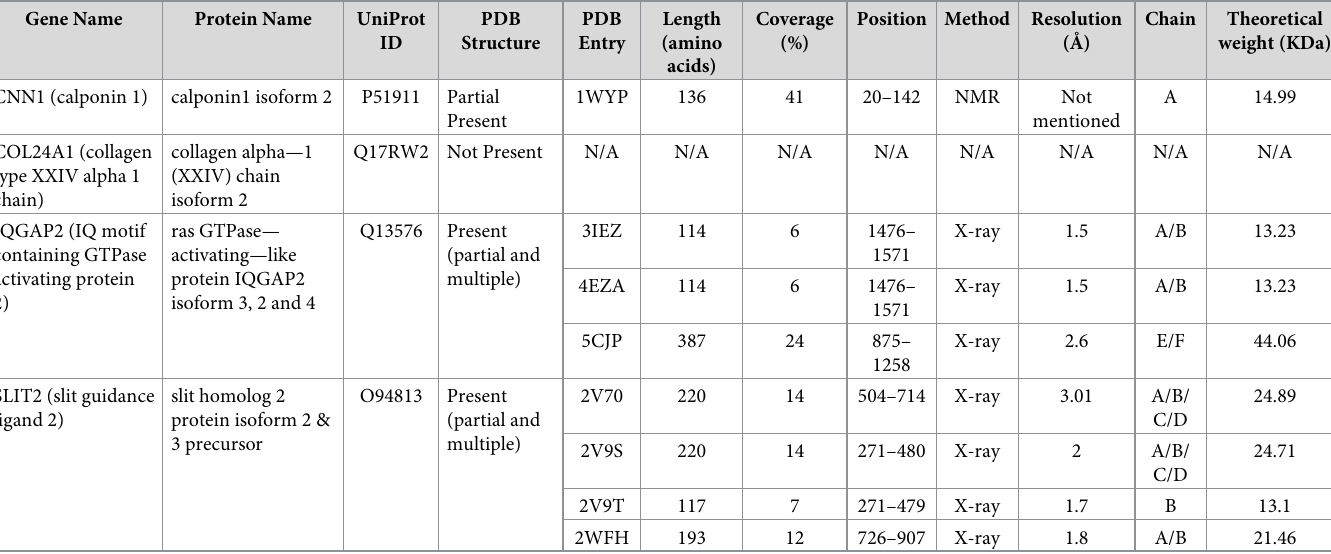
Table 6. PDB structural coverage of identified PTB-related genes.